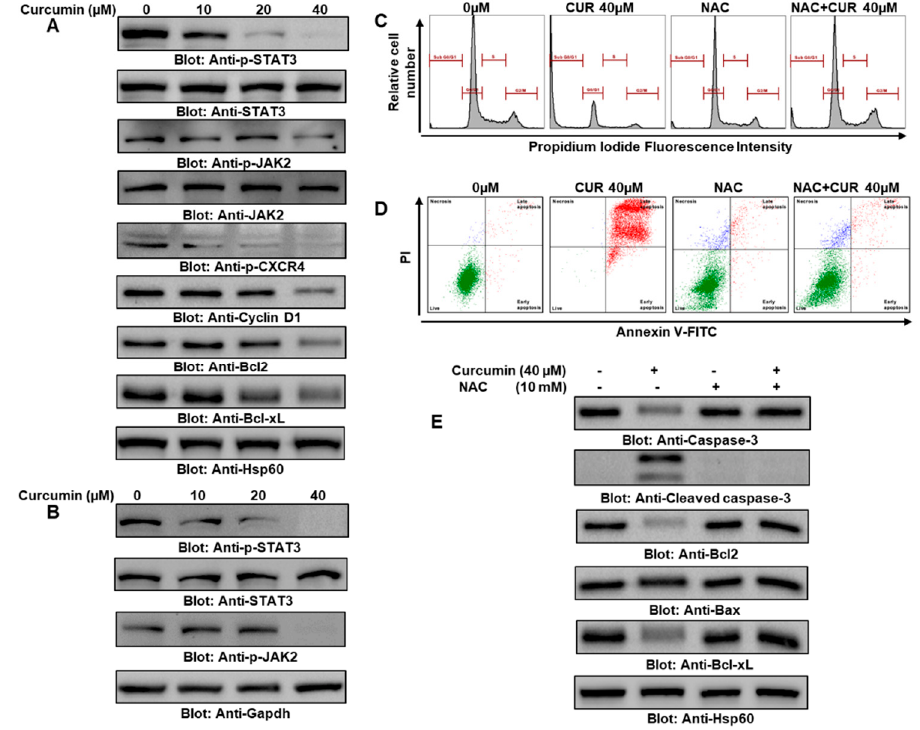
Figure 2. Curcumin suppressed the constitutive JAK/STAT3 signaling pathway and upregulated reactive oxygen species (ROS) content to induce apoptosis. ( A ) BCPAP and ( B ) TPC-1 cells were treated with 10 µ M, 20 µ M, and 40 µ M of curcumin for 24 h. After cell lysis, equal amounts of proteins were separated by SDS-PAGE, transferred to a PVDF membrane, and immunoblotted with antibodies against p-STAT3, STAT3, p-JAK2, JAK2, Cyclin D, pCXCR4, Bcl2, Bclxl, and Hsp60. ( C ) Curcumin induced ROS generation and oxidative stress, which are involved in cell cycle arrest and apoptotic cell death in PTC cells. N -acetyl cysteine (NAC) pretreatment with abrogated curcumin induced an increase in the SubG0 fraction in PTC cells. BCPAP cells were pretreated with 10 mM NAC followed by 40 µ M curcumin for 24 h, and the cell cycle fraction was measured by flow cytometry. ( D ) BCPAP cells were pretreated with 10 mM NAC followed by 40 µ M curcumin for 24 h, and apoptosis was measured by staining with fluorescein-conjugated Annexin V and propidium iodide (PI) and analyzed by flow cytometry. Data are expressed as the mean ± the SD. ( E ) NAC pretreatment in PTC cells reversed curcumin-mediated apoptosis. BCPAP cells were pretreated with 10 mM NAC and then subsequently treated with 40 µ M curcumin. Cells were lysed and separated using SDS-PAGE, transferred to a PVDF membrane, and immunoblotted with antibodies such as caspase-3, cleaved caspase-3, Bcl2, Bax, and Hsp60. Curcumin, CUR; cisplatin,